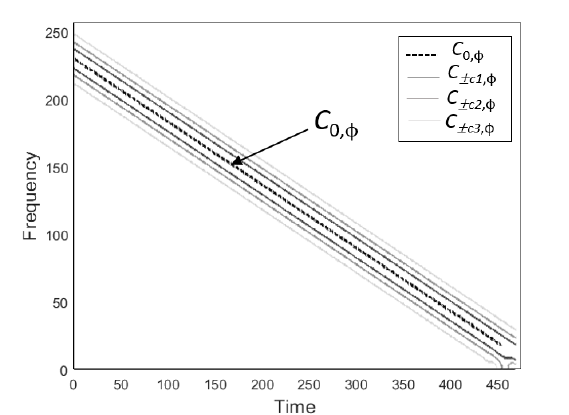
Figure 4. Plot of some characteristic curves in the time-frequency plane related to a single linear mode—the dashed line represents the ridge curve ( c = 0).